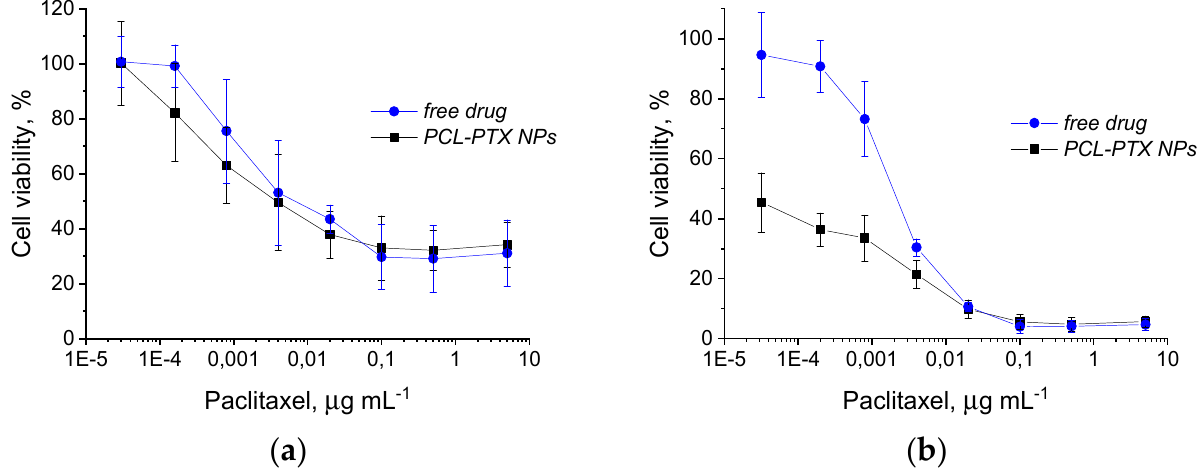
Figure 7. Viability of HeLa cells after 24 h ( a ) and 48 h ( b ) of incubation with different concentrations of free PTX (blue circles) and PTX-loaded MPEO 44 - b -PCL 17 NPs (black squares).